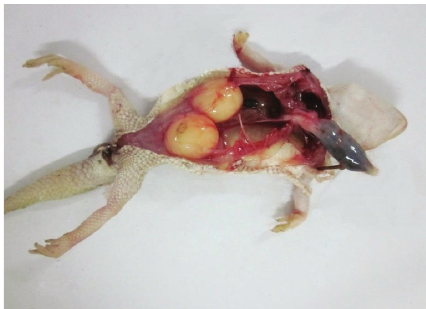
Figure 4: Teratoscincus bedriagai on 5